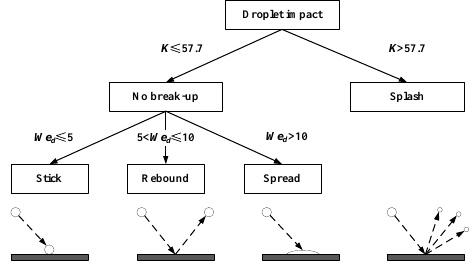
Figure 1. Interaction of droplets and the wall.